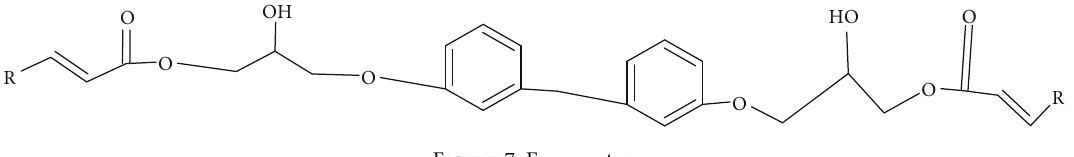
Figure 7: Epoxy ester.